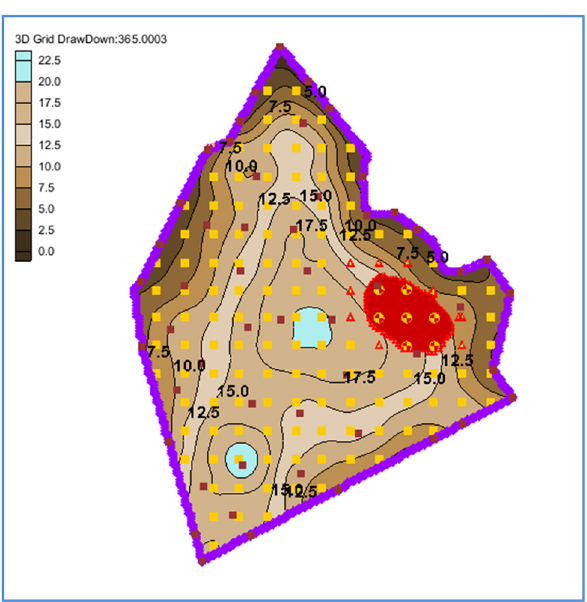
Figure 11: Drawdown after 18 h of operation with a discharge equal to 650 m 3 /day for each